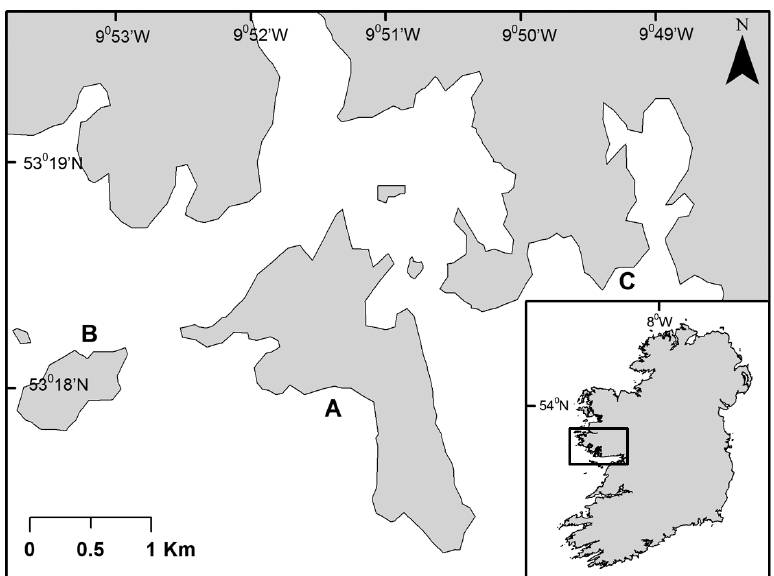
Fig. 2. Location of sampling sites at Mweenish Island, Galway, Ireland. A: ben- thic sampling site; B: suspended longline sampling site in Ard Bay; C: location